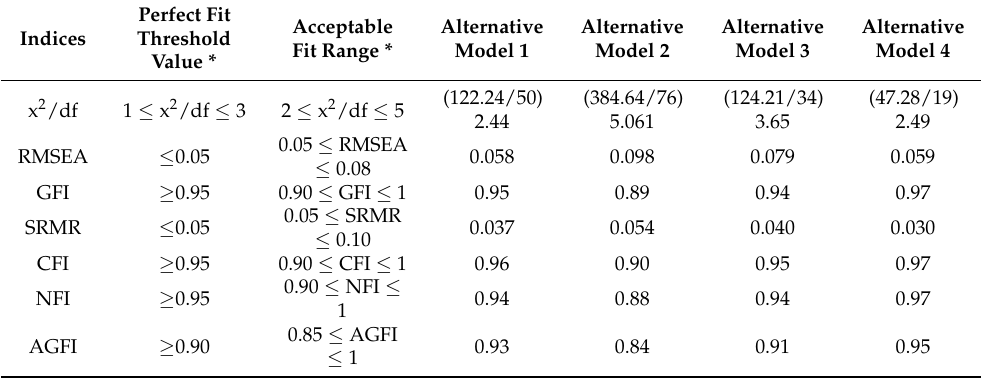
Table 12. The Comparison of Alternative Models.